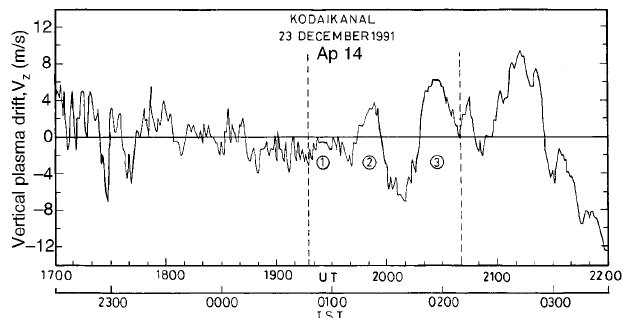
Fig. 1. Variation of F region vertical plasma drift, V on the night of 23/24 December 1991 ( A quasi-periodic perturbations (period 25–35 min) in V interval 0047–0210 IST (1917–2040 UT) indicated by the two vertical dashed lines